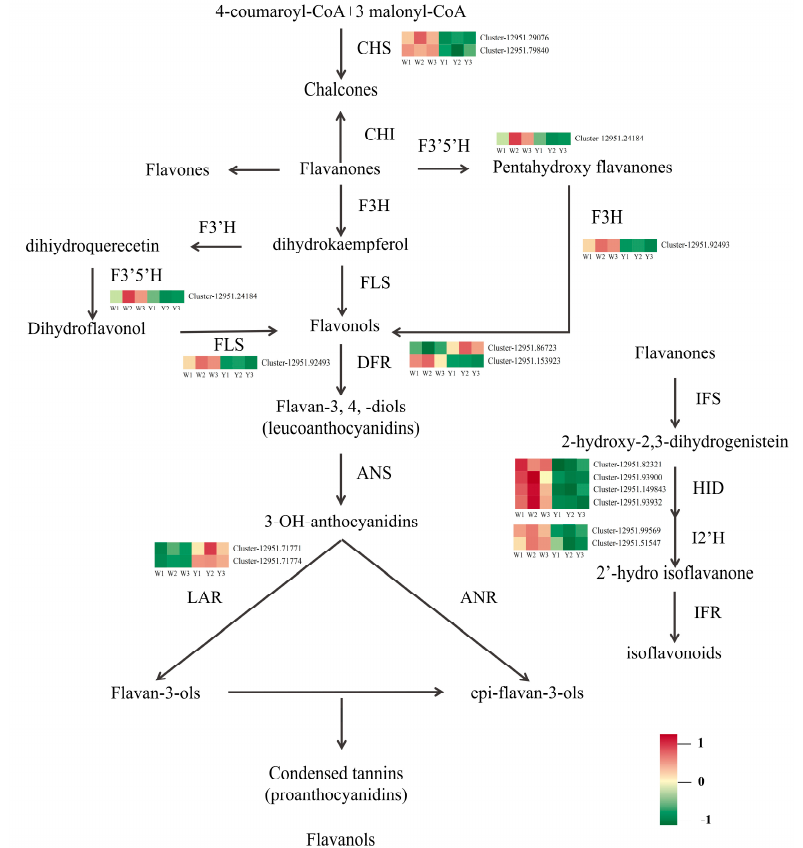
Figure 9. Schematic diagram of the flavonoid biosynthesis pathway related to flower pigment in the R. liliiflorum . Enzyme acronyms and expression patterns are shown beside each metabolic step and the direction of synthesis is marked with black arrows. The RNA-seq expression pattern of each gene is shown in heatmaps. The colour scale represents log2-transformed FPKM (fragments per kilobase of exon per million mapped reads) values. W vs. Y represent white and yellow parts of petals in R. liliiflorum , respectively.